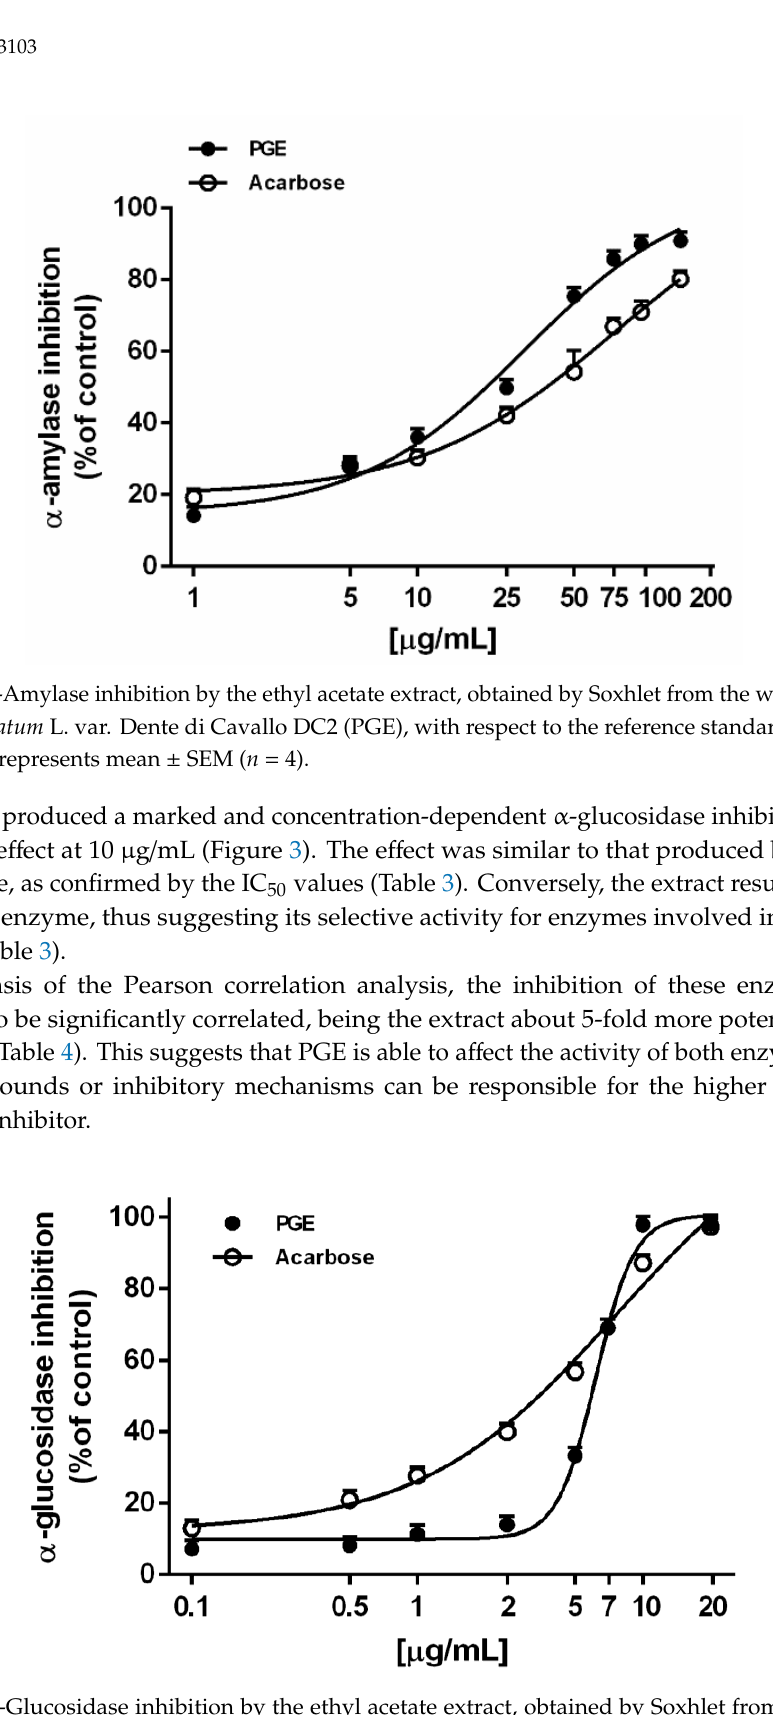
Figure 3. α -Glucosidase inhibition by the ethyl acetate extract, obtained by Soxhlet from the waste peel of Punica granatum L. var. Dente di Cavallo DC2 (PGE), with respect to the reference standards acarbose. Each value represents mean ± SEM ( n = 4).